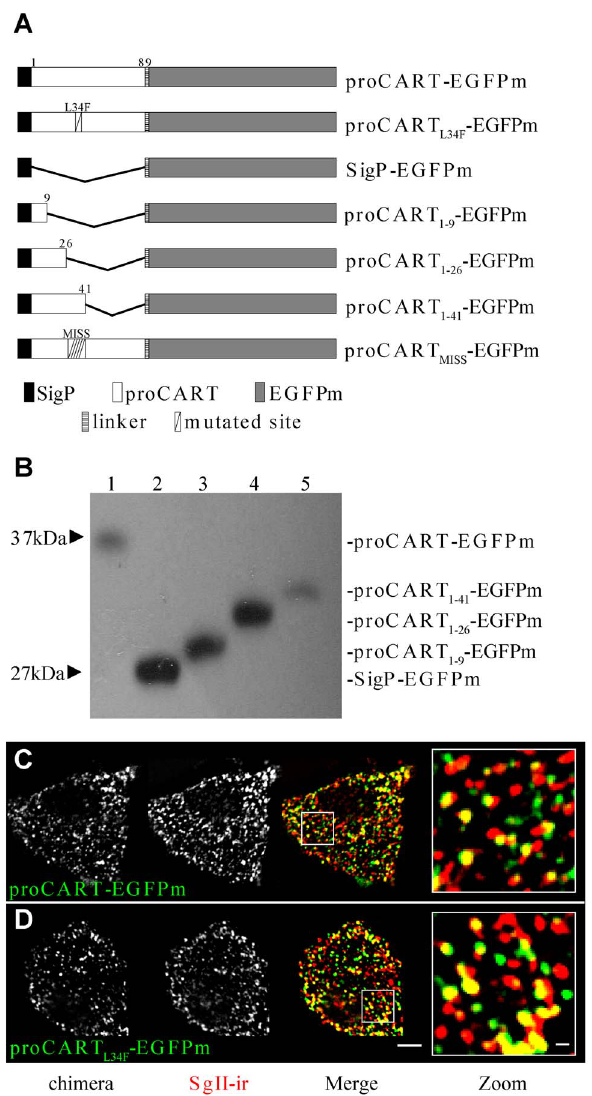
Figure 1. proCART-EGFPm and proCART L34F -EGFPm colocalize with SgII-ir. (A) Schema depicting all CART-EGFPm fusion proteins used in the study. Positions of amino acid residues from proCART 1–89 fragments are indicated by the numbers alongside each fusion protein. (B) Fusion proteins were expressed in PC12 cells and cell lysates were analyzed by western blotting with anti-GFP antibody. Confocal images of PC12 cells transfected with proCART-EGFPm (C) or proCART L34F - EGFPm (D). Aldehyde-fixed cells were subjected to immunofluores- cence protocols using SgII antibody. (C y D) Left panel: EGFPm signal. Middle: SgII-ir signal. Right panel: Merge of both signals. Zoom from merge image showing spots with both signals. Scale bar: 2 m m; zoom: 0.25 m